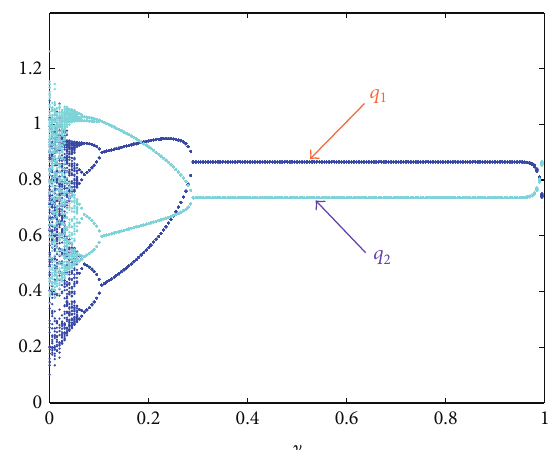
Figure 22: Bifurcation diagram of system (13) with ] ∈ (0, 1] , 𝛼 1 = = 1.46 . 2.13 and 𝛼 2